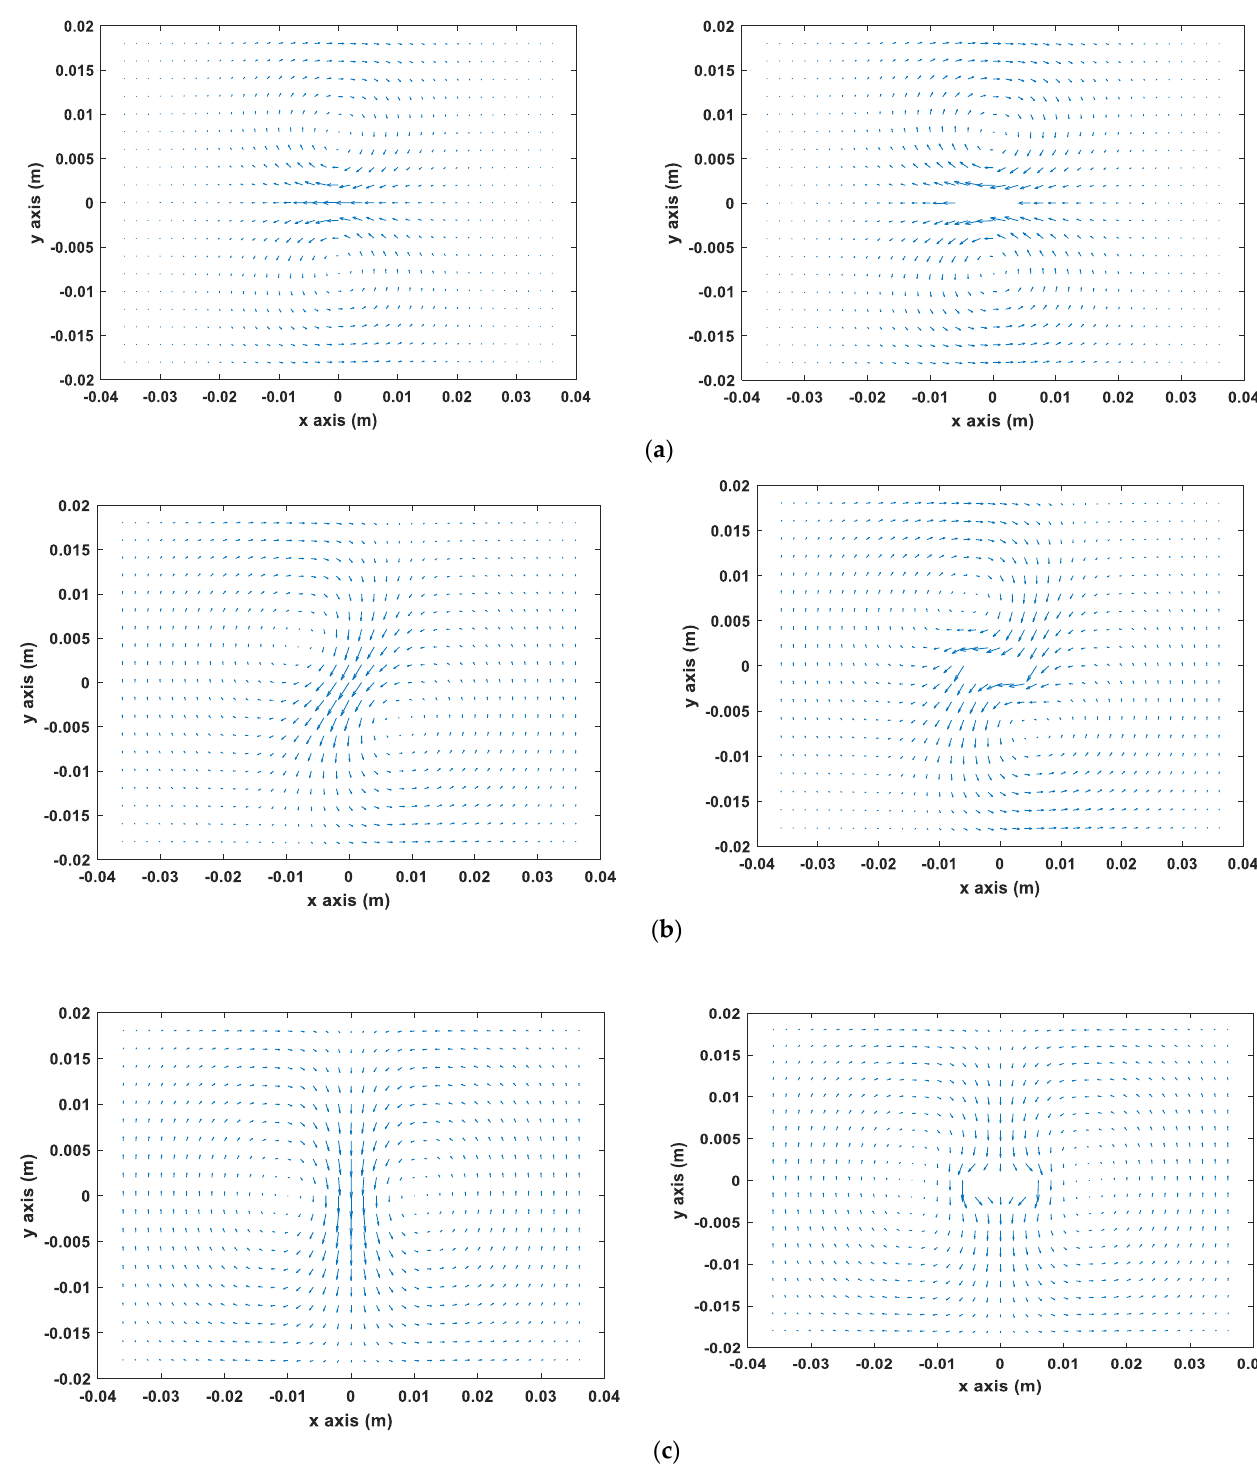
Figure 2. The flow of eddy current induced on the non-magnetic tested sample without/with the crack ( a ) rotation angle 0°, ( b ) rotation angle 45°, ( c ) rotation angle 90°. crack ( a ) rotation angle 0 ◦ , ( b ) rotation angle 45 ◦ , ( c ) rotation angle 90 ◦